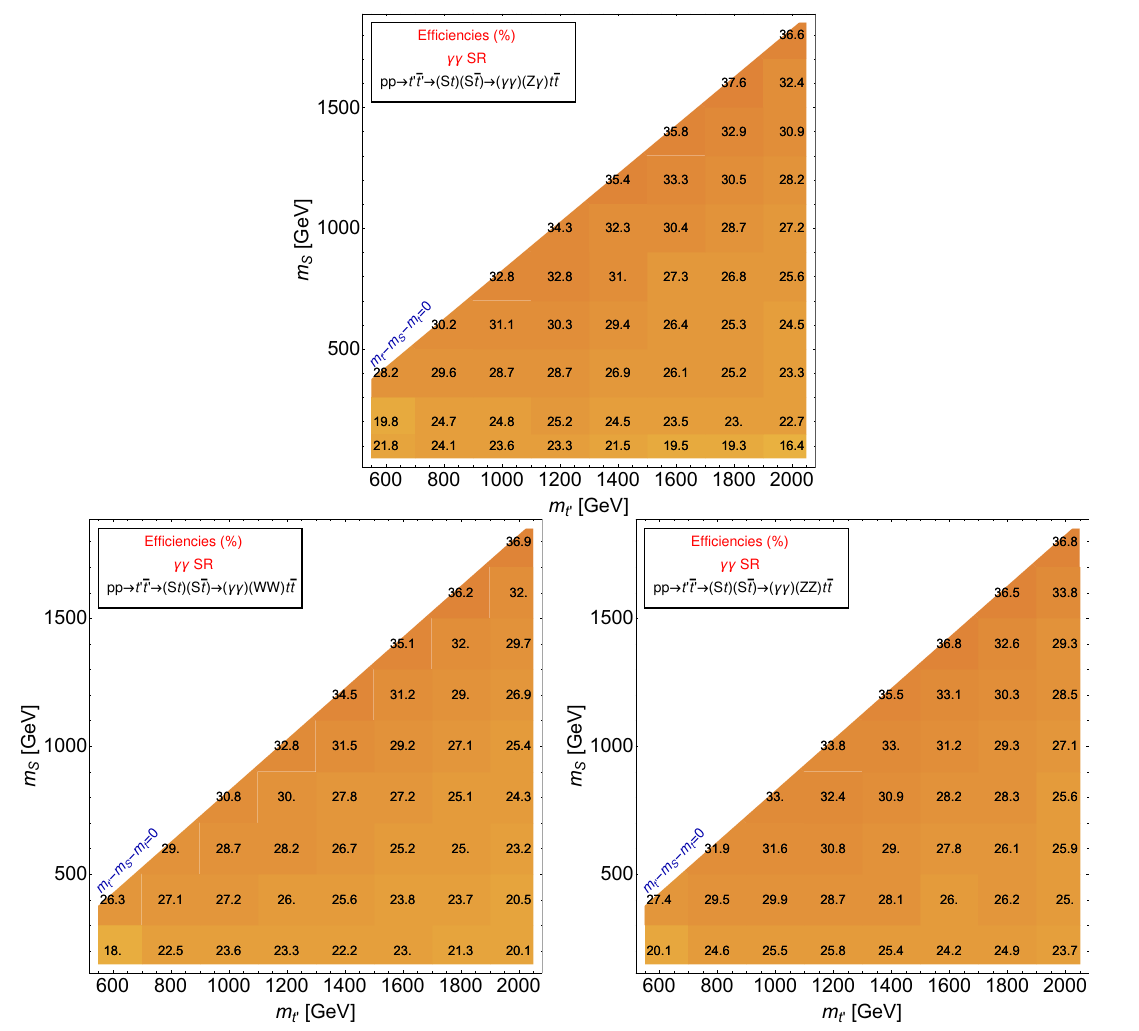
Figure 18 . E(cid:14)ciencies for the (cid:13) (cid:13) SR and for channels where at least one of the two S decays into (cid:13) (cid:13)